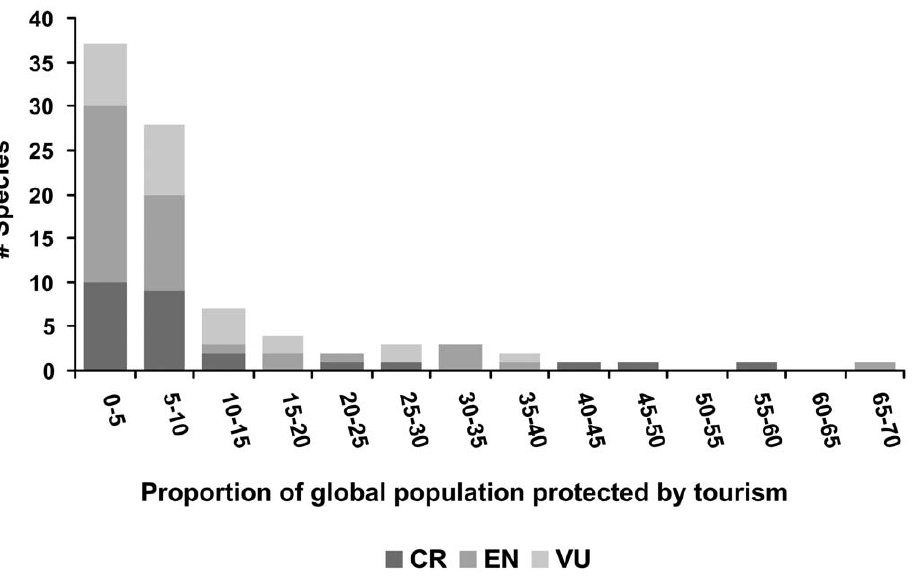
Figure 1. Proportions of remaining global populations of threatened mammal species for which conservation funding is derived from tourism revenues. CR, Critically Endangered; EN, Endangered; VU, Vulnerable.